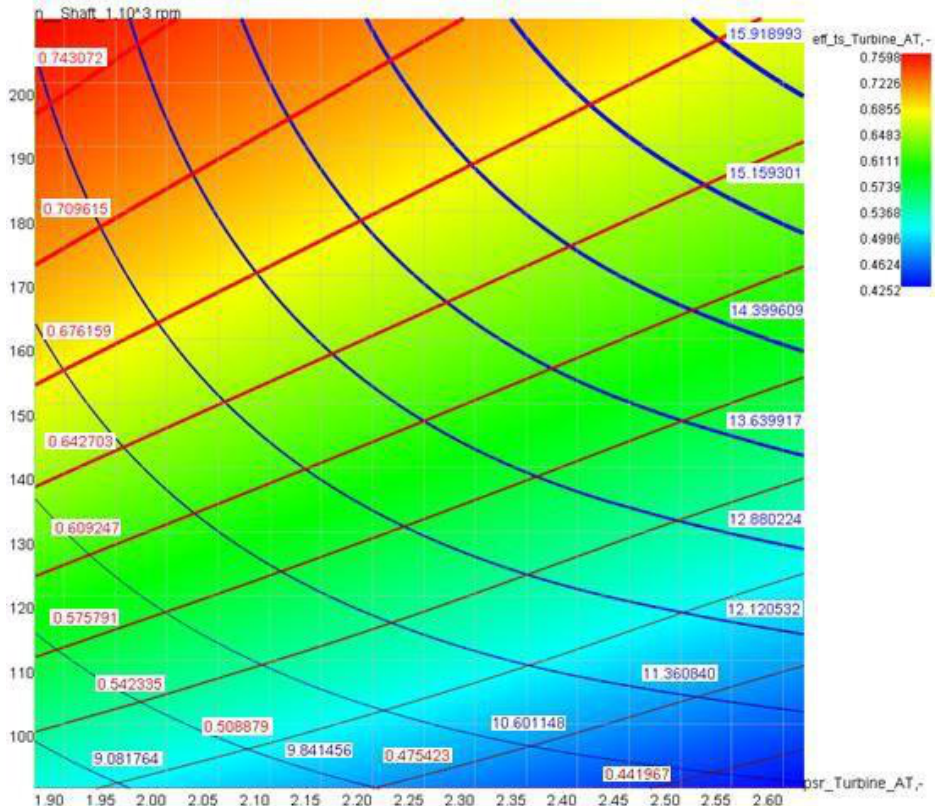
Figure 16. Prismatic Range 1 turbine map ( y -axis: shaft speed in rpm (1000 s); x -axis: turbine pressure ratio). The legend at the top right-hand side indicates the range of total-to-static turbine efficiency.